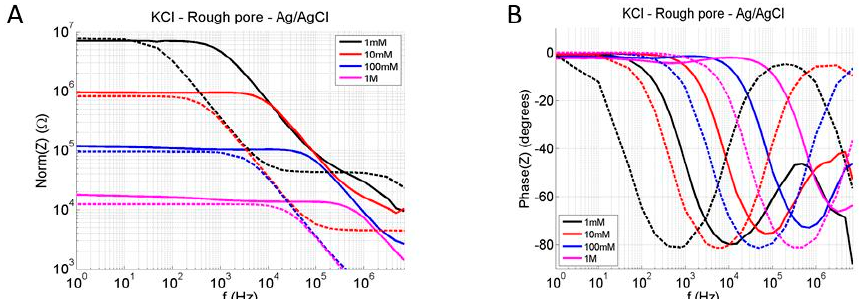
Figure 3. Validation of the numerical model by comparing measured impedances (continuous lines) against computed impedances (dashed lines) for different KCl solutions. ( A ) Bode plots of impedance norm. ( B ) Bode plots of impedance phase.